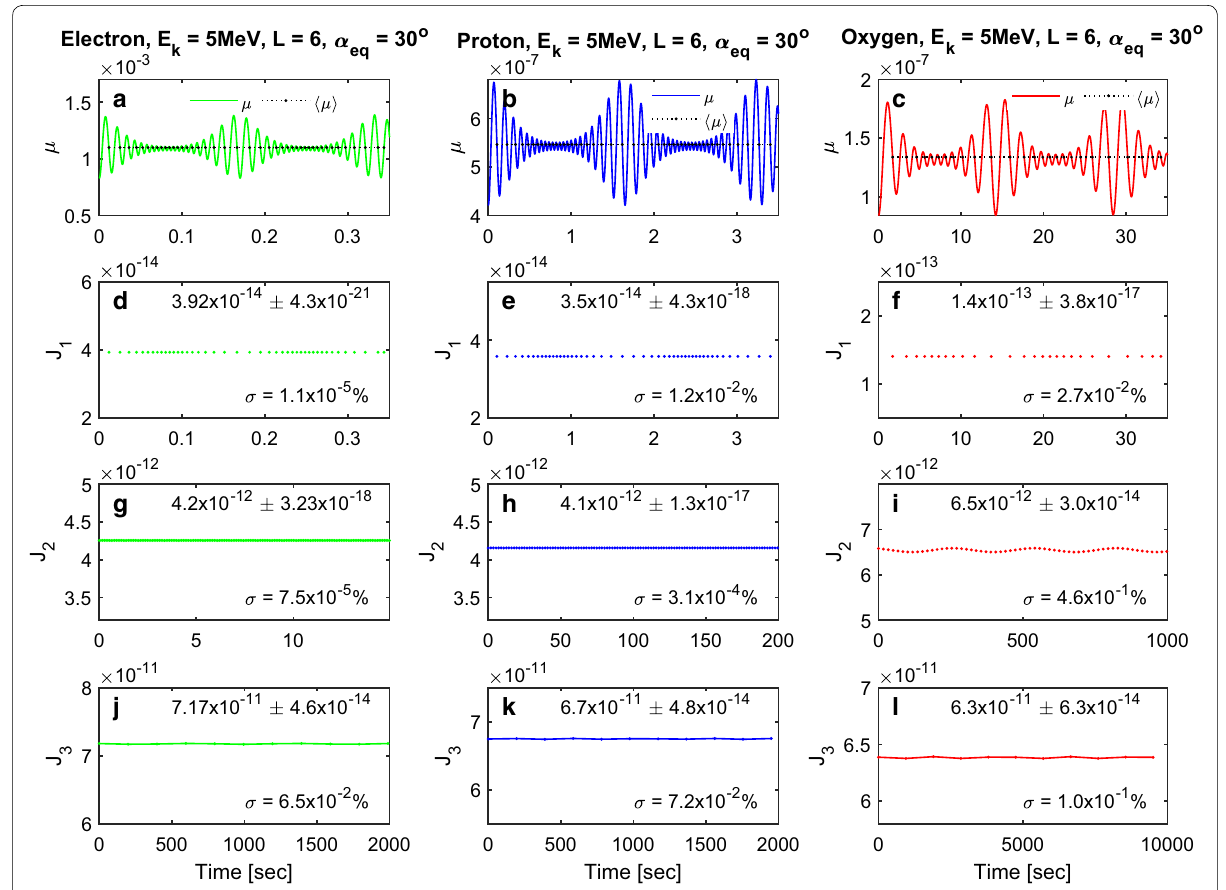
Fig. 11 Variation of magnetic moment µ and three adiabatic invariants J 1 , J 2 and J 3 estimated from the simulation for electron ( a , d , g , j ), proton ( b , e , h , k ), and oxygen ( c , f , i , l ) having energy 5 MeV, L = 6 , α eq = 30 ◦ , ψ = 90 ◦ . The mean value of adiabatic invariants (cid:31) J (cid:30) and their standard deviation σ are mentioned in the respective panels to demonstrate their